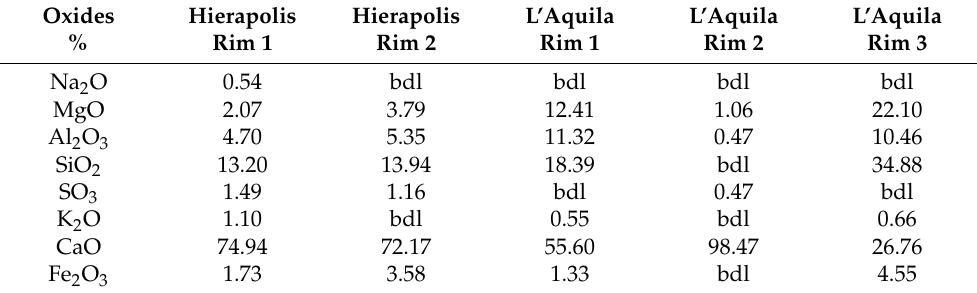
Figure 7. Microphotographs of a sub-rounded cluster of red clay in a bedding mortar of Camponeschi Palace (18th century) in L’Aquila under ( a ) PLM, xpl, and ( b ) EDS SEM map of Ca; ( c ) EDS SEM map of Al; and ( d ) EDS SEM map of Si. Table 5. Microchemical spot analyses of rim portions of binder of Hierapolis and L’Aquila samples.